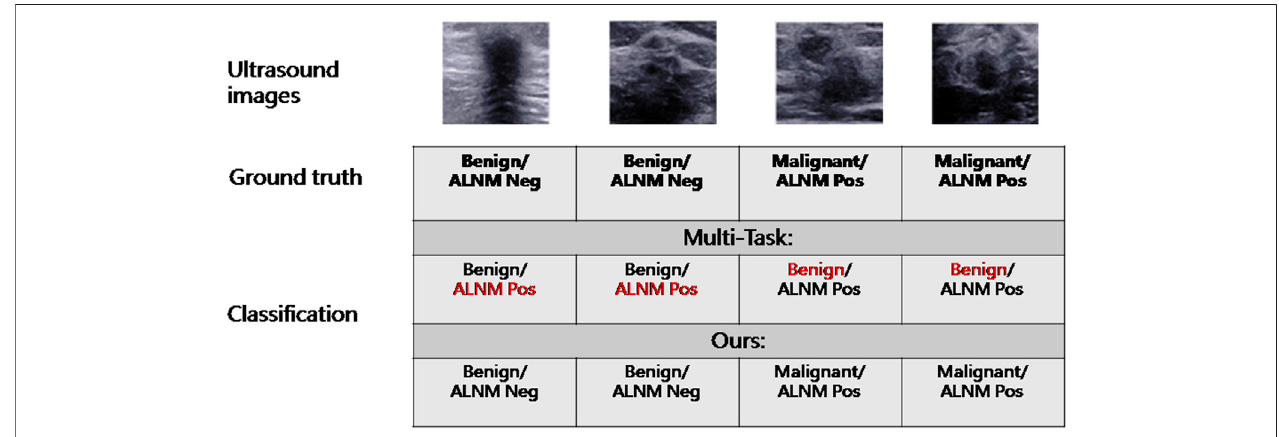
FIGURE 4 | Example of reduced inconsistency by introduction of a hierarchical-loss function.